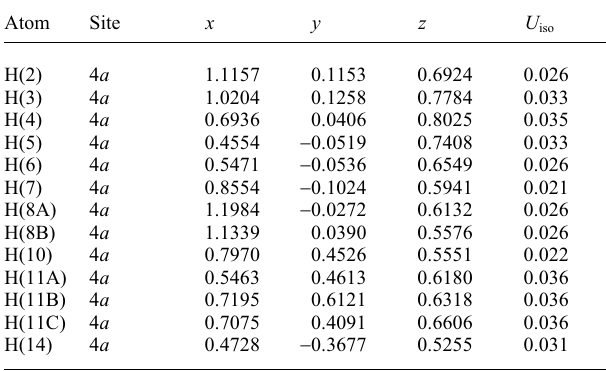
Table 2. Atomic coordinates and displacement parameters (in Å 2 )